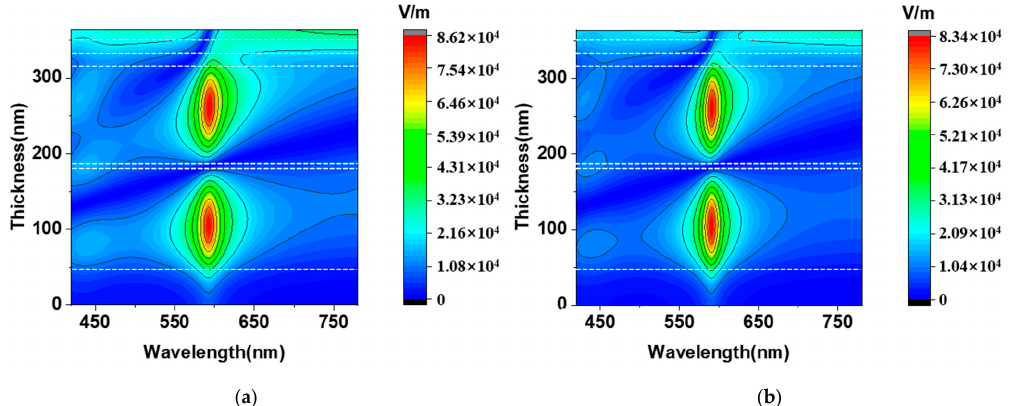
Figure 7. ( a ) Variation of the electric field of amorphous structure with wavelength (peak electric field: 8620 V/m); ( b ) variation of the electric field of crystalline structure with wavelength (peak value: 8340 V/m).